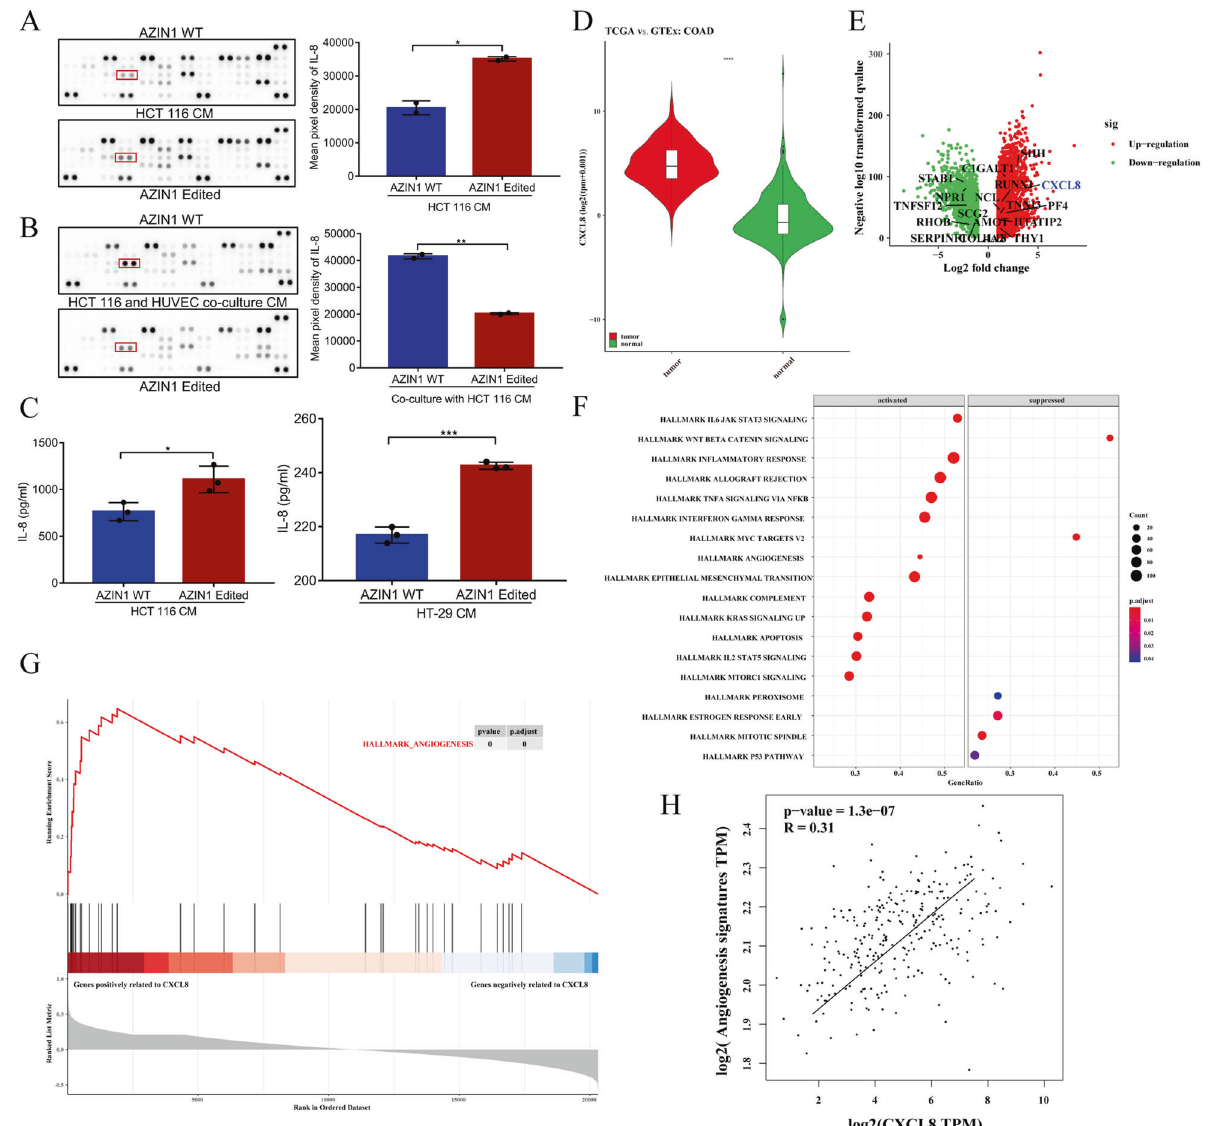
Fig. 4 The differential factors secreted by edited AZIN1 compared with WT group. A Proteome pro fi ler human angiogenesis array to detect the differential factors in HCT 116 cells and B co-culture of HCT 116 and HUVEC. Mean expression values of differential factors after densitometric quanti fi cation are shown. The grayscale value of IL-8 is circulated by a red rectangular box. C ELISA Quantitative determination of IL-8 from conditioned medium of each group. Data are presented as means ± SD. n = 3. Data were analyzed with unpaired Student ’ s t test. * P < 0.05, ** P < 0.01, *** P < 0.001. D IL-8 mRNA expression was shown in colon cancer compared to para-cancer tissue. E Volcano plot revealed differentially expressed genes between colon cancer and para-cancer tissue. F Enrichment of genes with the hallmark pathways by